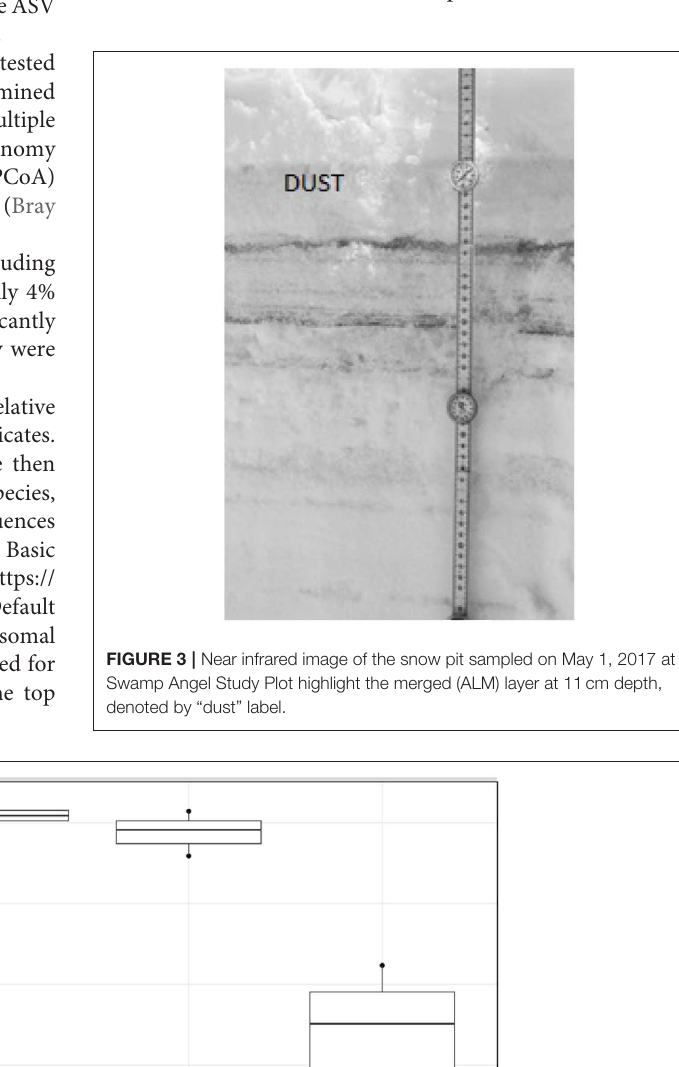
Frontiers in Earth Science |